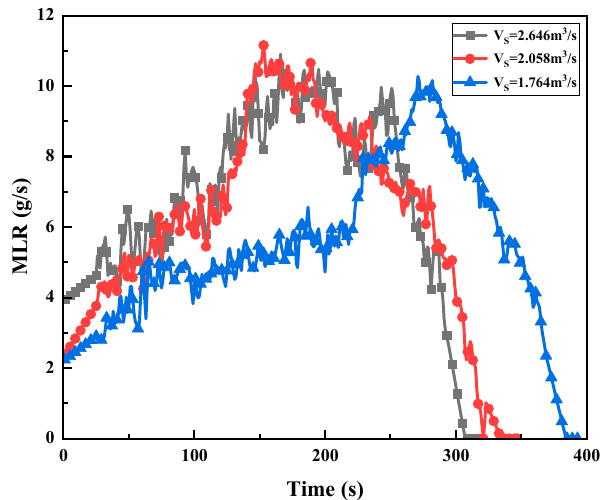
Figure 3. Variation in mass loss rate with time under different air volume conditions.